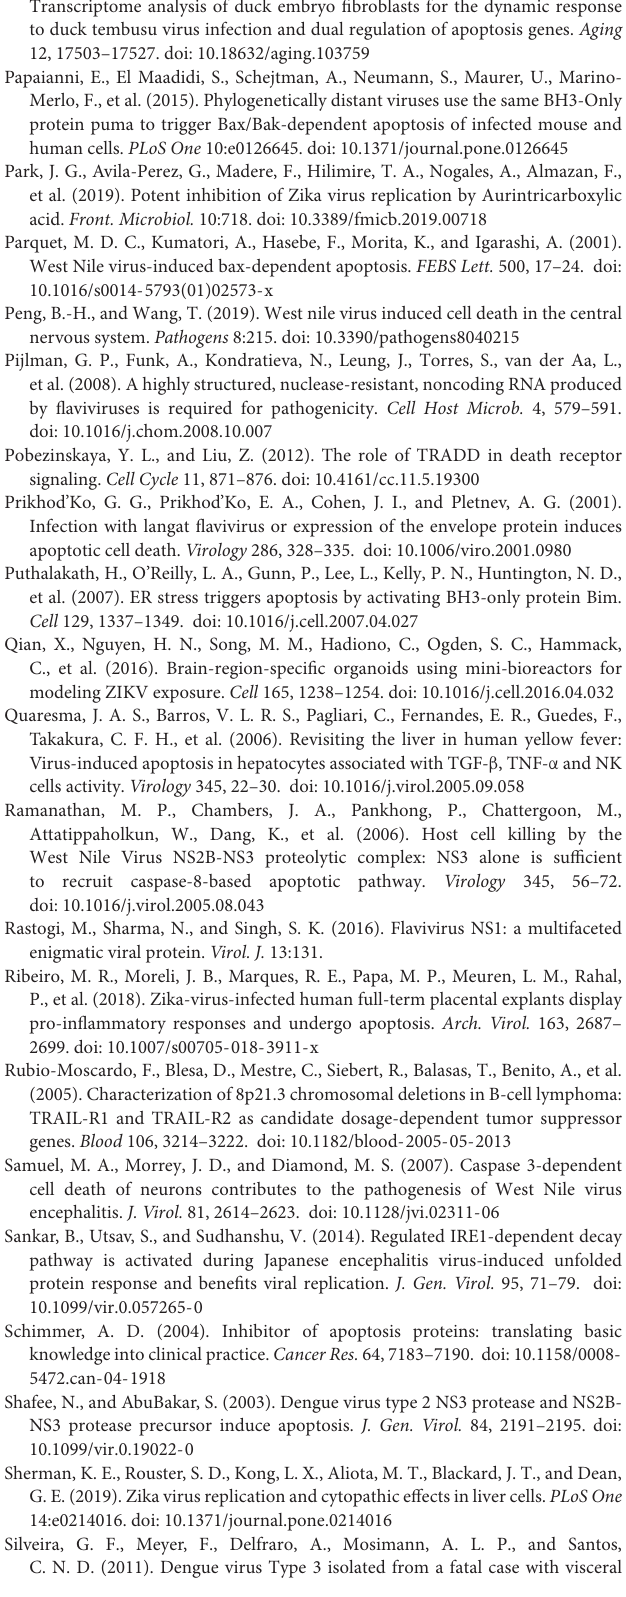
Frontiers in Microbiology |